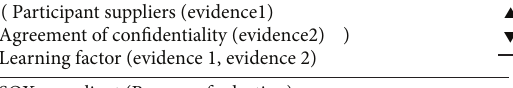
Figure 7: Suppliers Selection Process. Deductive Decision Making Protocol.